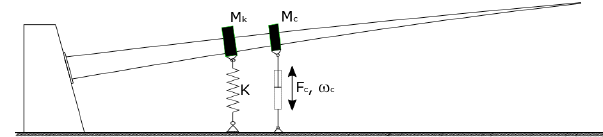
Figure 5. Spring element application to blade fatigue test setup.